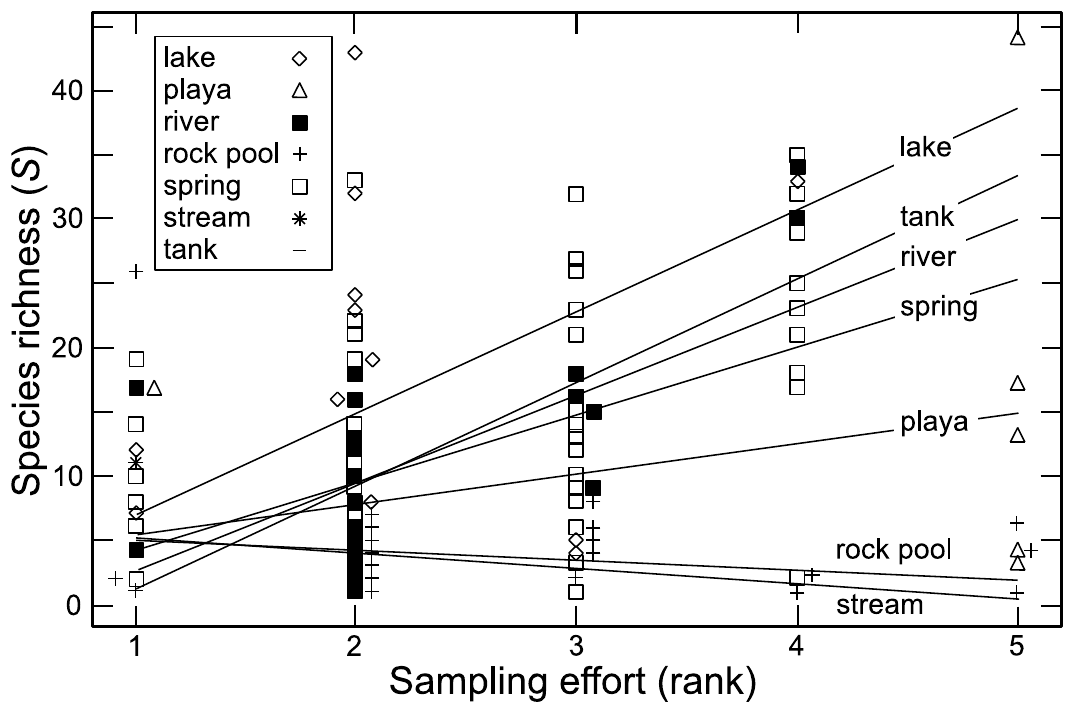
Figure 2. Observed species richness ( S ) as a function of sampling e ff ort in 236 Chihuahuan Desert aquatic sites over 20 years. We shifted some of the data points to reveal their location; some remain obscured by other data points. Lines are linear regressions of the data analyzed separately for each site type. We ranked sampling e ff ort as follows: 1 = 1 sampling event; 2 = 2–5 events; 3 = 6–10 events; 4 = 10–20 events; 5 = > 20 events.